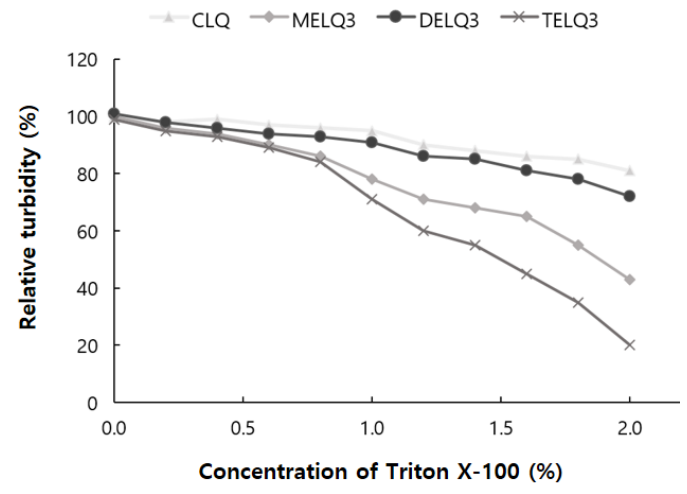
Figure 2. Relative turbidity of nanoliposomes (CLQ, MELQ3, DELQ3, and TELQ3) at different concentrations of Triton X-100.